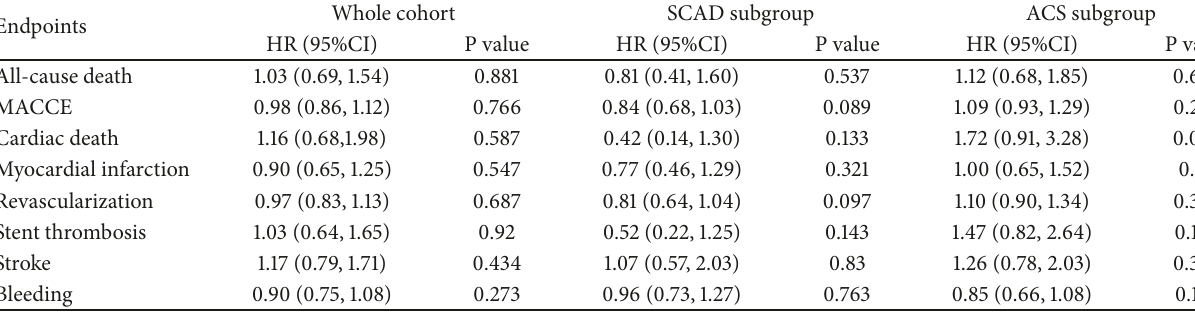
Table 3: Multivariate Cox regression analysis in whole cohort, SCAD subgroup, and ACS subgroup.